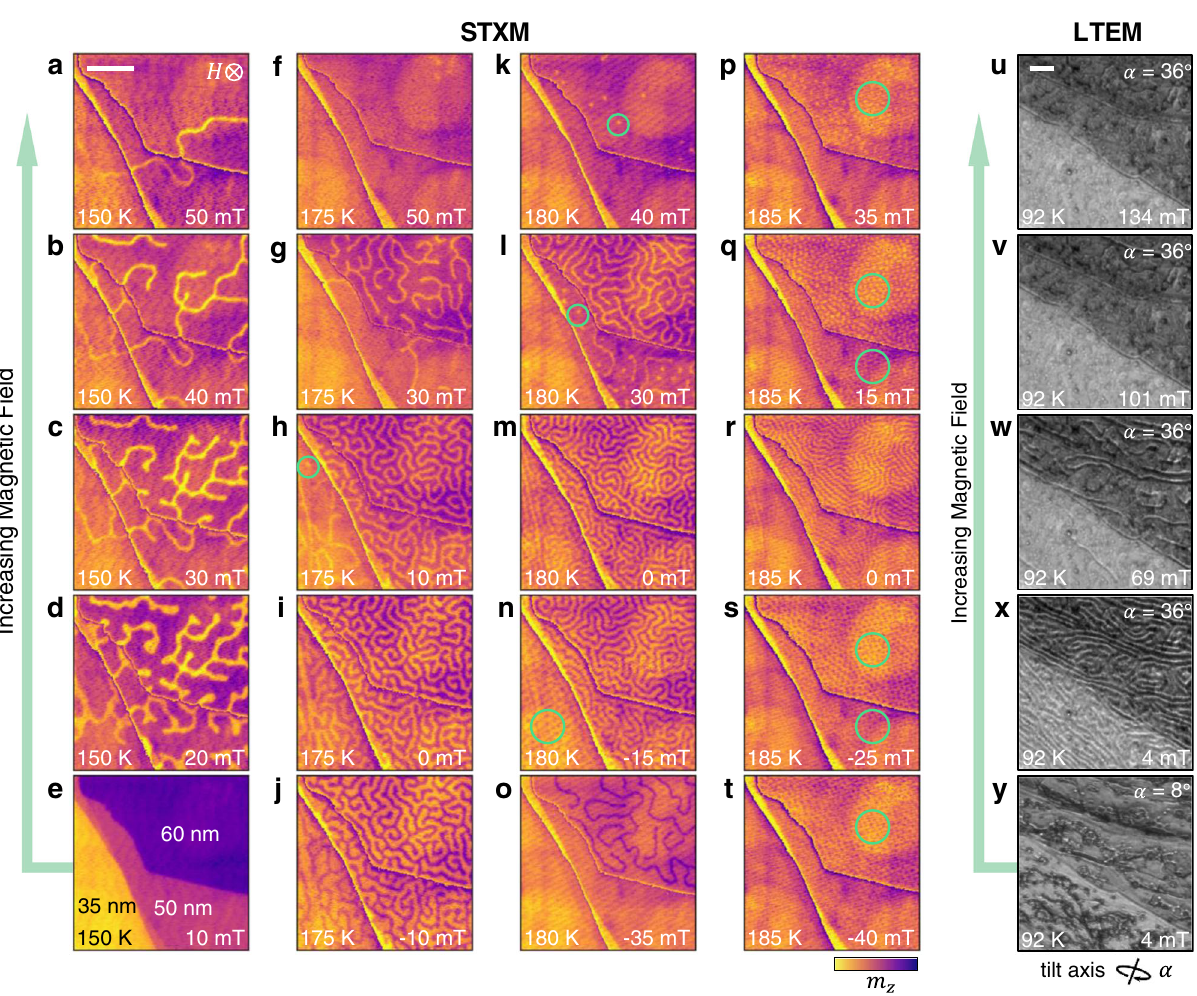
Fig. 3 Real-space imaging of spin textures. a – t Magnetic contrast scanning transmission x-ray microscopy (STXM) images of the FGT fl ake region of interest measured following the fi eld sweep protocol from – 250 to 250 mT at a range of temperatures. In each image, the contrast of each thickness region has been normalised to highlight the magnetic structures (original thickness contrast without domains can be seen in panel ( e )). The colourmap indicates the signal proportional to the out-of-plane magnetisation m z . Regions containing skyrmions are highlighted with a green circle. u – y , Lorentz transmission electron microscopy (LTEM) images acquired with increasing fi eld after zero- fi eld cooling. The sample tilt angle α is labelled. The scale bars are 1 μ